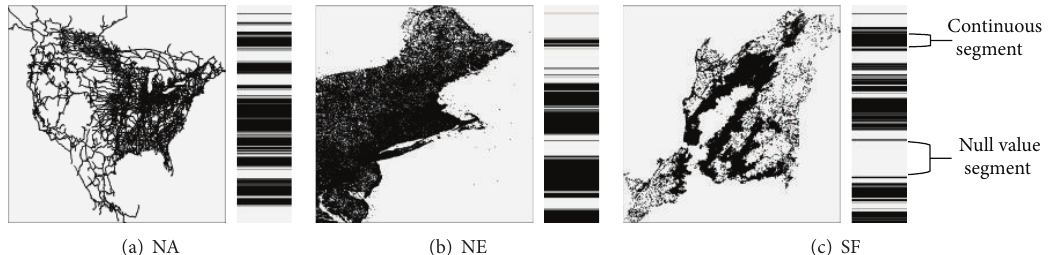
Figure 2: Visualization of POIs’ indexes.